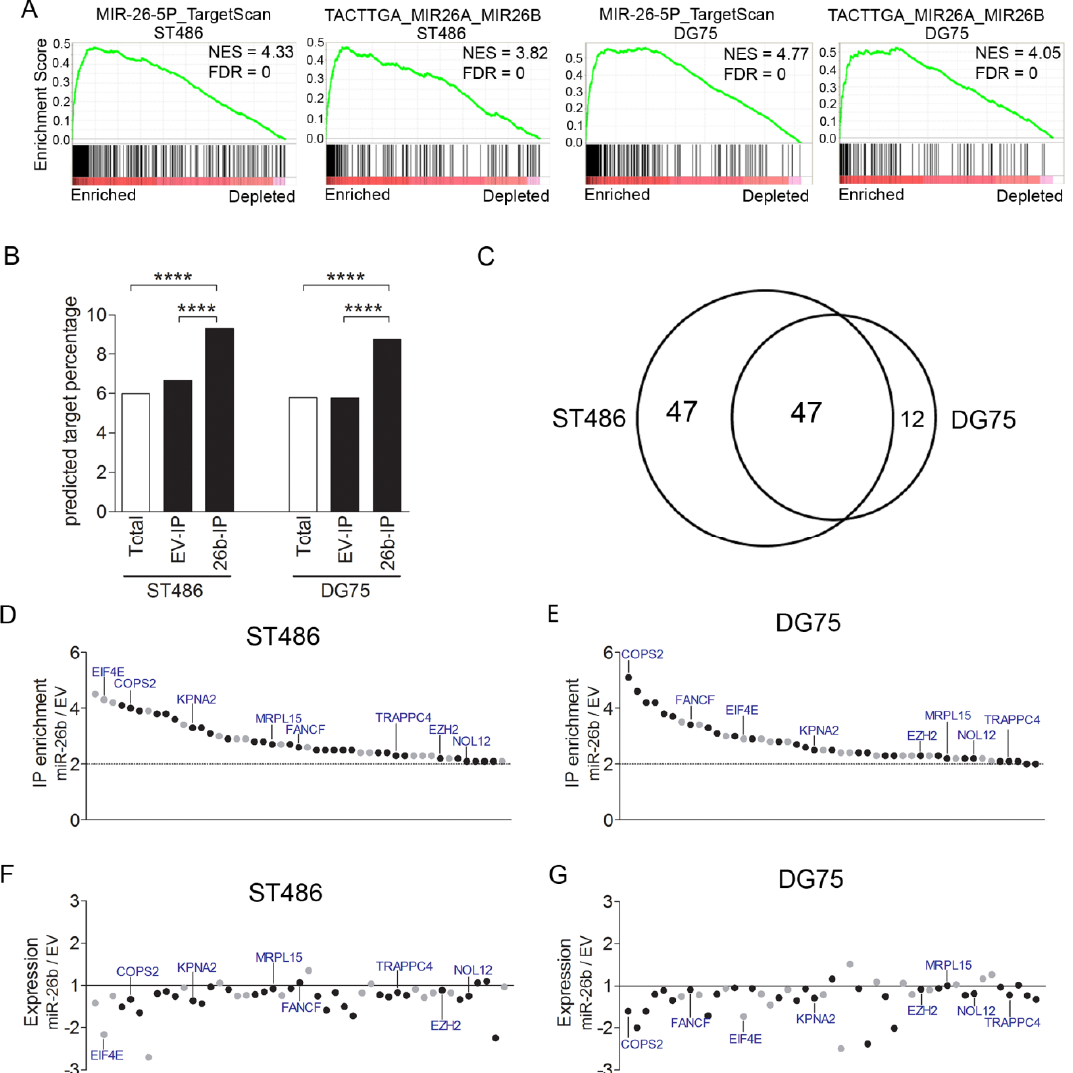
Figure 3. Identification of the miR-26b-5p target genes. ( A ) Enrichment plots of gene sets for the miR-26-5p targets. Pre-ranked gene set enrichment analysis was performed on average miR-26b IP / T, over empty vector (EV) IP / T fold-change values. ( B ) Comparison of the percentage of TargetScan-predicted targets of miR-26b-5p among the consistently expressed genes, and Ago2-IP enriched genes. ( C ) The overlap of the miR-26b-5p targets identified in ST486 and DG75, upon miR-26b overexpression. **** p < 0.0001. ( D , E ) IP / T ratios of the miR-26b-5p targets identified by Ago2-RIP-Chip upon miR-26b-5p overexpression, relative to EV in ST486 and DG75. The black dots indicate genes with predicted miR-26b-5p binding sites. ( F , G ) Fold changes in expression of the 47 genes in ST486 and DG75, upon miR-26b-5p overexpression, compared to the EV control. Same order of genes as in D and E. The 8 genes indicated in panels D to G are identified in the CRISPR / Cas9 screen shown in Figure